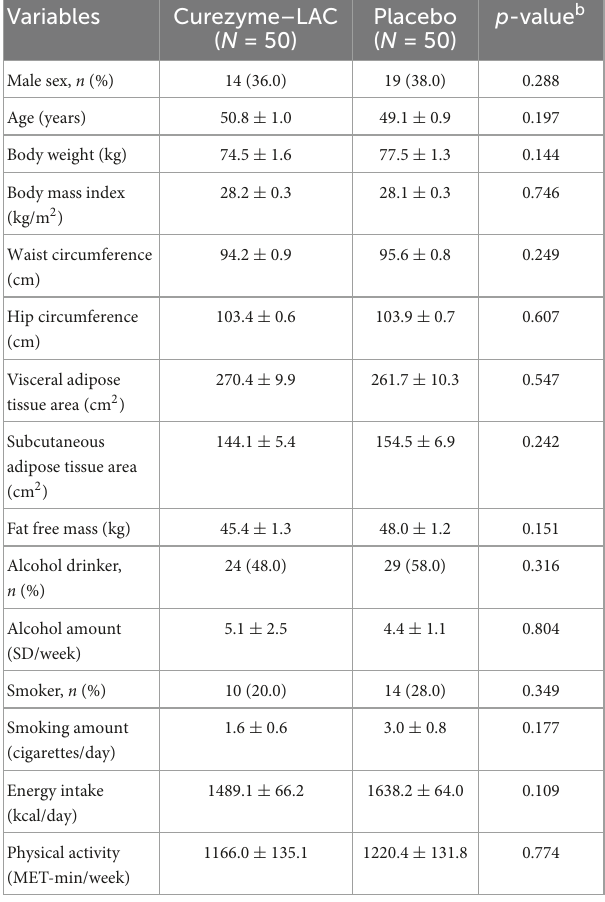
TABLE 1 Baseline characteristics of participants a